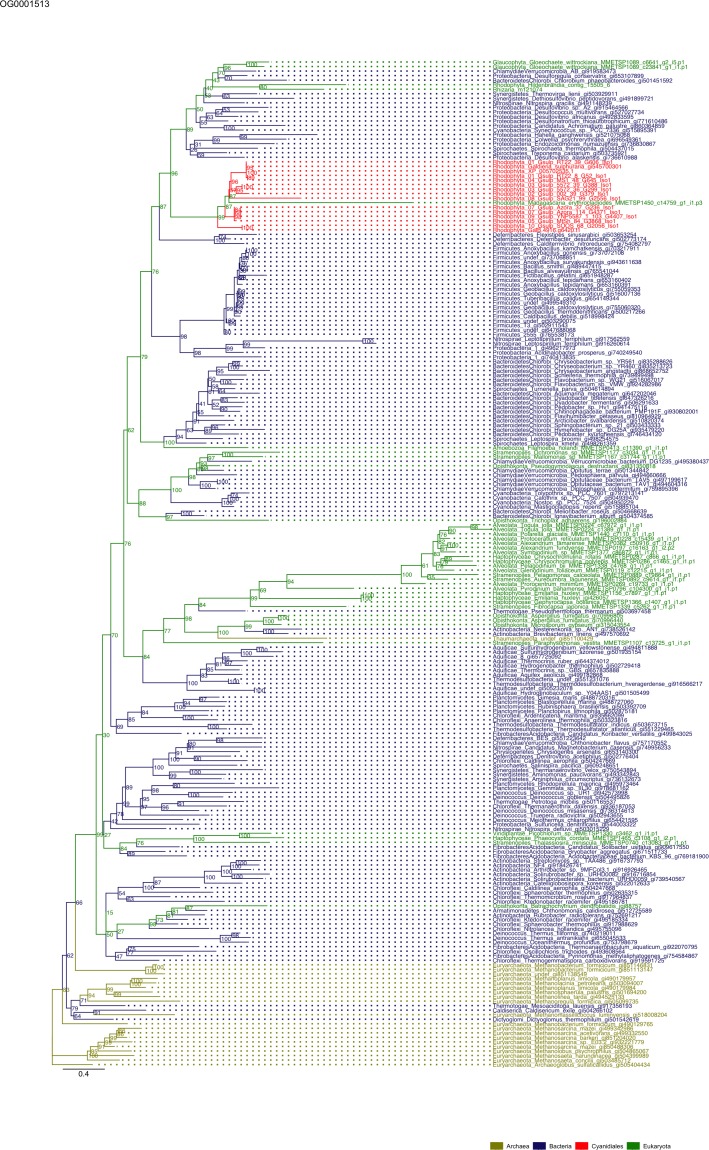
Sequence tree of orthogroup OG0001513.The tree is based on amino acid sequences. Archaea (yellow), Bacteria (blue), Cyanidiales (red), Eukaryotes including other red algae (green). Branches containing Cyanidiales sequences are highlited in red.